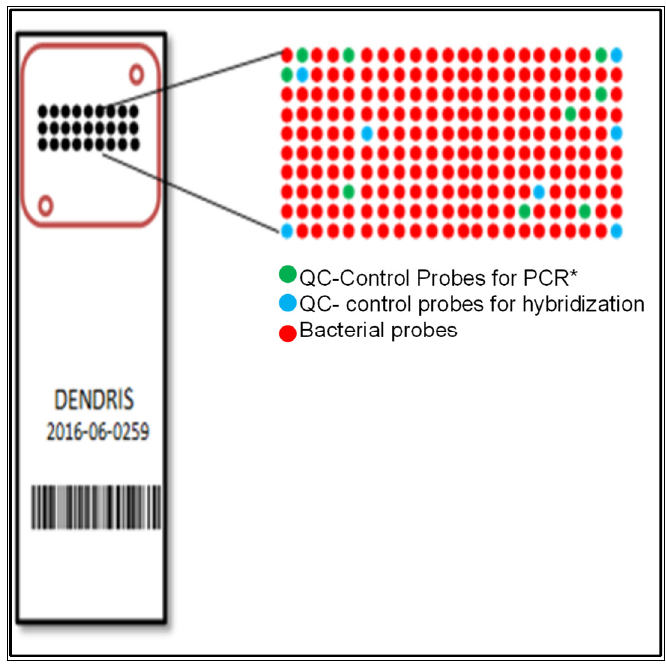
Figure 1. Description of the DendrisChips ® ; QC mean quality control.